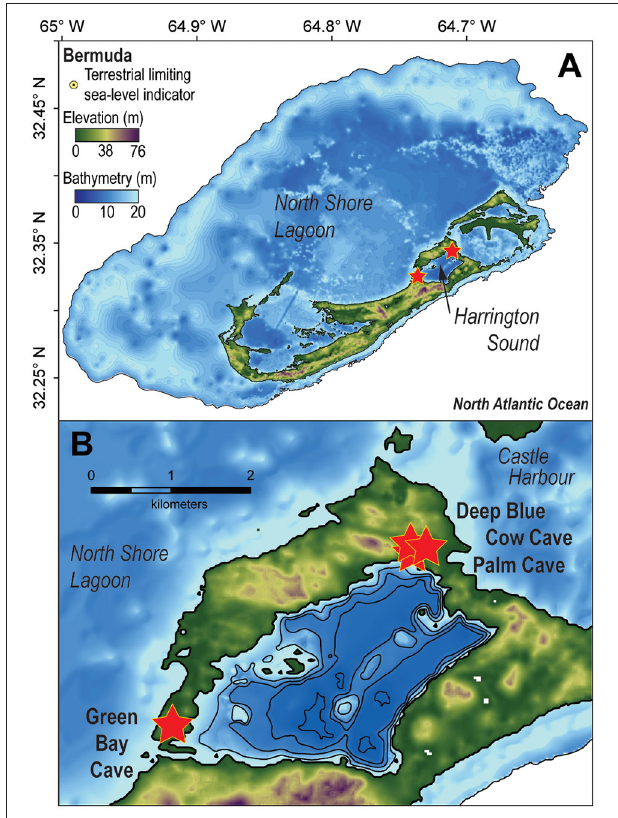
FIGURE 2 | (A) Digital elevation model of Bermuda in the North Atlantic Ocean. (B) Detailed map of Harrington Sound plotted in ArcGIS. Red stars indicate study site